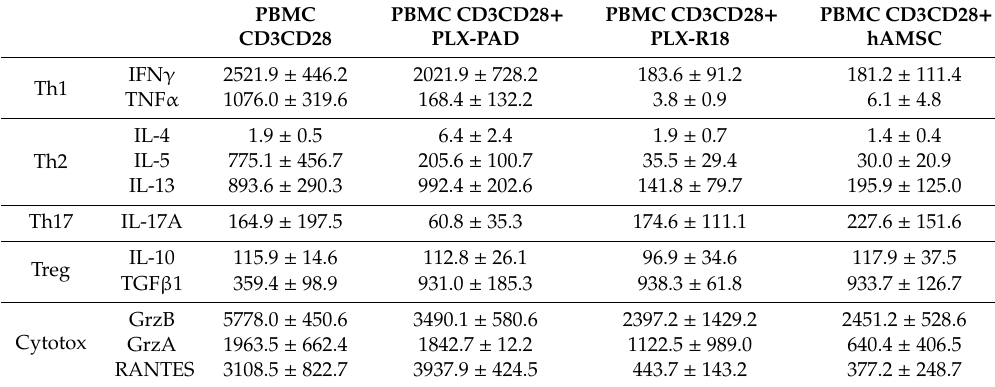
Table 1. Cytokine and chemokine analysis on the e ff ect of either maternal or fetal MSC on PBMC stimulated with CD3CD28 mAbs. Allogeneic PBMC were stimulated with CD3CD28 mAbs for six days and co-cultured or not in the presence of maternal PLX-PAD cells, fetal PLX-R18, or fetal hAMSC cells at a PBMC:MSC ratio of 1:1. After six days, the supernatant was collected and analyzed for the expression of a panel of cytokines and chemokines. Data are indicated as mean ± SD ( n = 4). PBMC PBMC CD3CD28 + PBMC CD3CD28 + PBMC CD3CD28 + CD3CD28 PLX-PAD PLX-R18 hAMSC IFN γ 2521.9 ± Th1